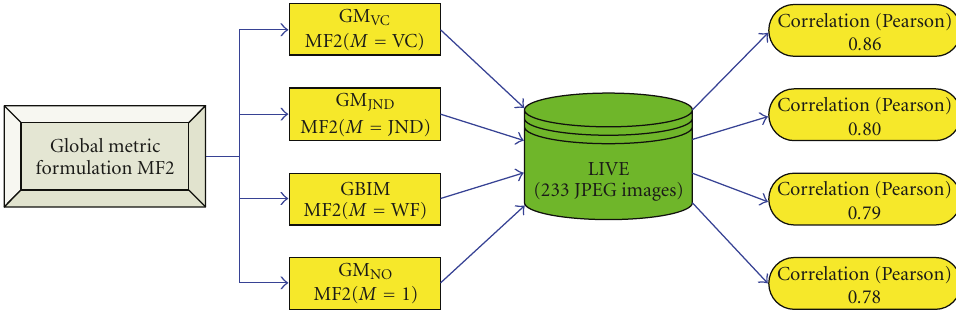
Figure 15: Illustration of the comparison of various HVS models: a blockiness metric (i.e., MF2) having four optional HVS models embedded is tested with the LIVE database, and the performance for each resulting metric is quantified by the Pearson correlation coe ffi cient.